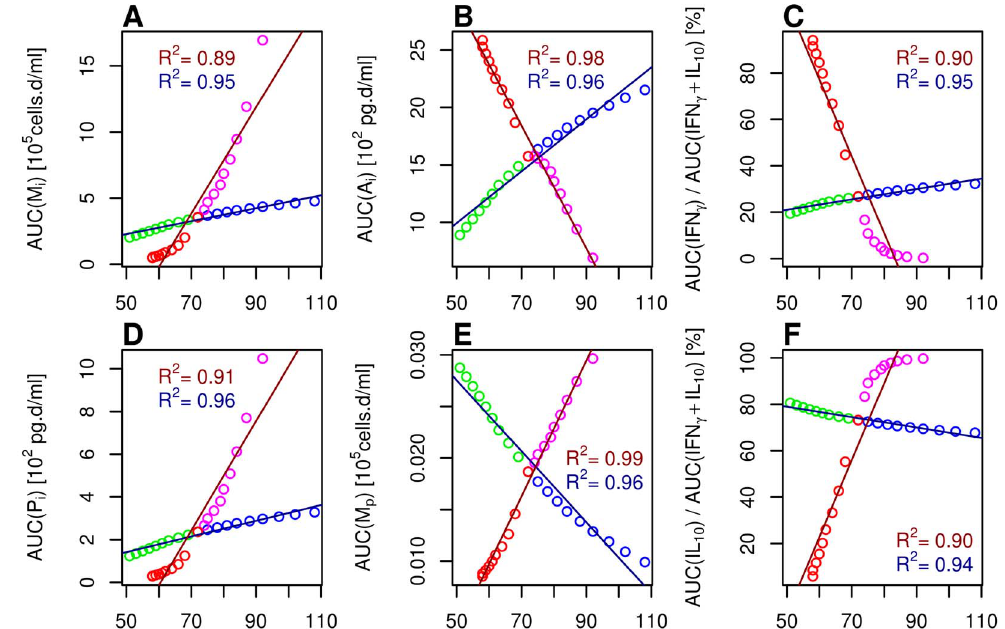
Figure 6. Linear regressions between the infection duration and immune components of interest. The immune components selected are the area under the curve (AUC) of A : infected macrophages ( M I ~ M L z M E ), B : innate antiviral cytokines ( A i ~ TNF a z IFN a ), D : pro-inflammatory cytokines ( P i ~ IL 1 b z IL 6 z IL 8 ), and E : phagocyting macrophages ( M P ); and the relative AUC of C : IFN c and F : IL 10 . Two regressions were performed for each component: (i) for scenarios SB ? SA (dark red), in which the antiviral cytokine synthesis is higher (S0 ? SB, red dots) or lower (S0 ? SA, magenta dots) than in the reference scenario; (ii) for scenarios S1 ? S2 (dark blue), in which the macrophage permissiveness is lower (S0 ? S1, green dots) or higher (S0 ? S2, blue dots) than in the reference scenario. Scenarios are defined in Table 2.